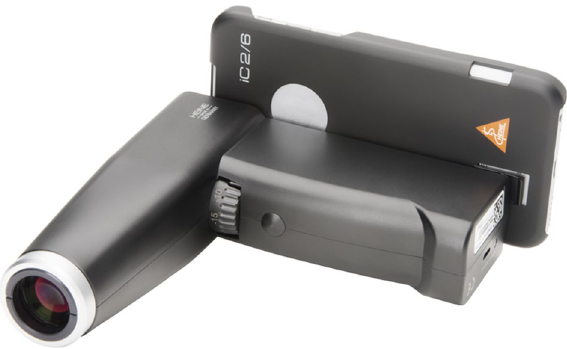
Figure 1. The smartphone-based fundus imaging device used in this study. Source: 31